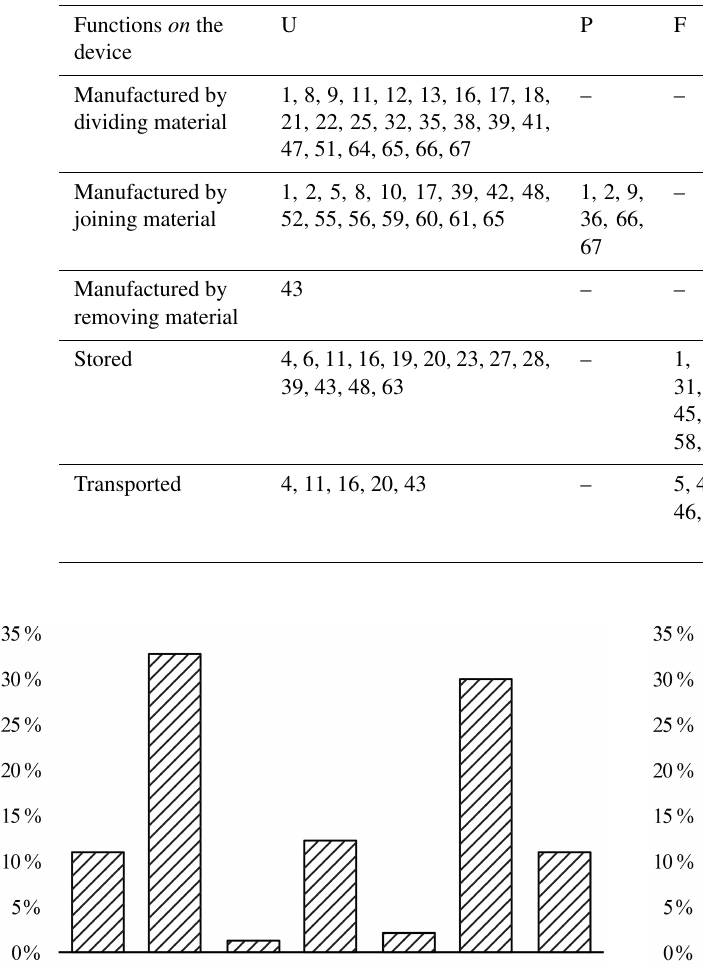
Table 3. We list each device’s number in rows corresponding with the functions performed on the device and columns of its corresponding fold states. See Table 2 for device numbers and references. Functions are labeled using the functional basis developed by Hirtz et al. (2002).